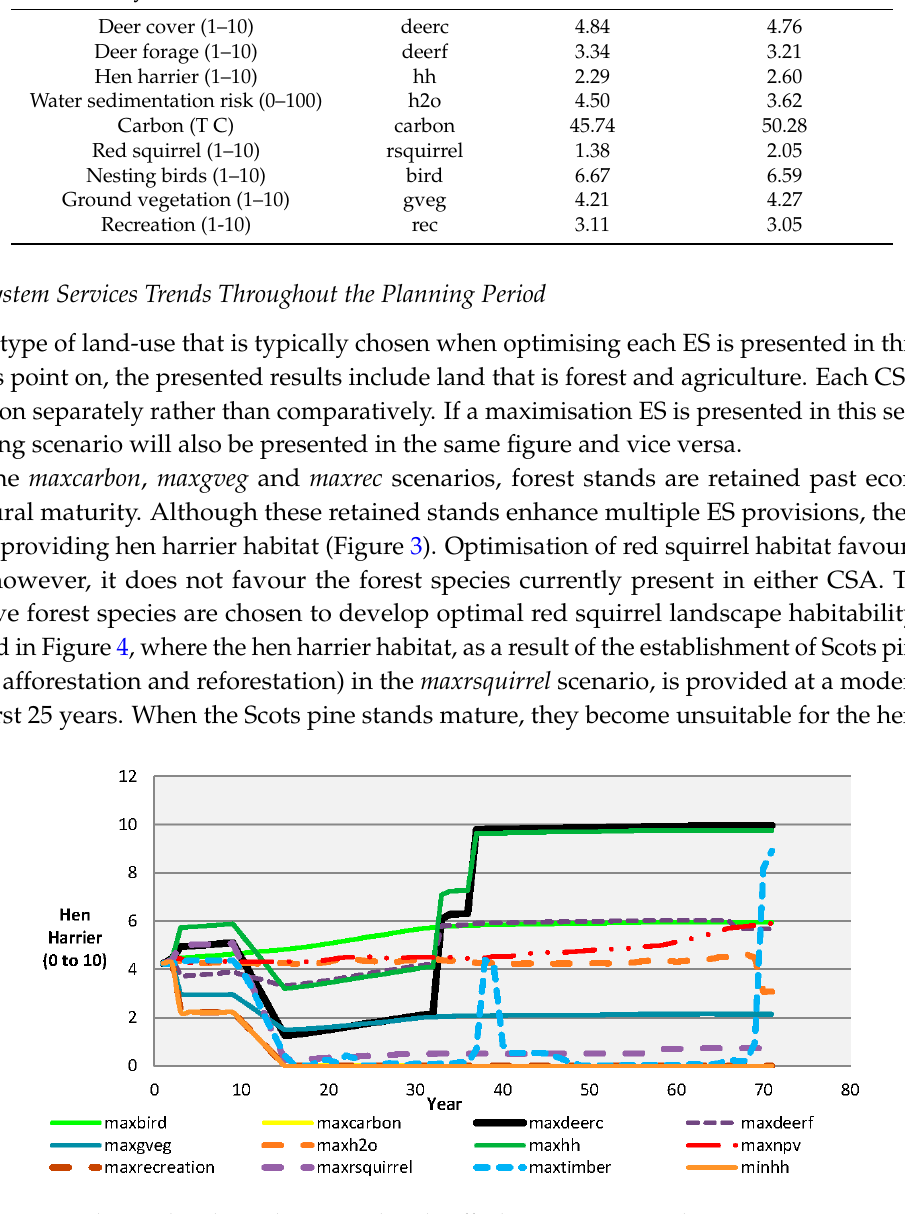
Figure 3. Hen harrier biophysical range and trade-off when maximising other ecosystem services over the planning period in the NewmarketM case study area. Maxcarbon , maxrecreation , follow a similar trend as minh.